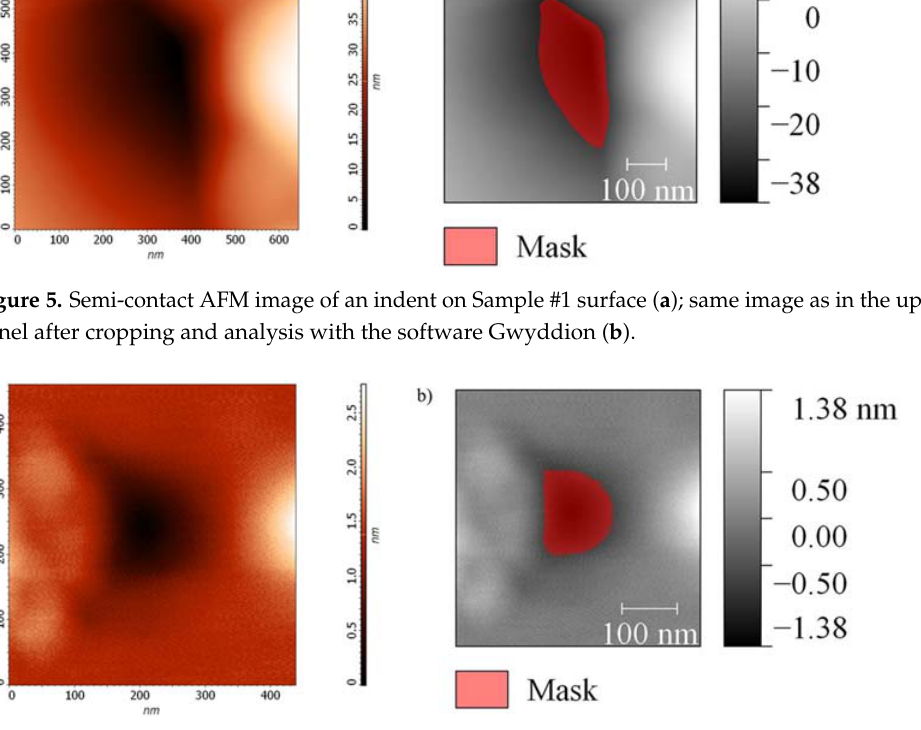
Figure 6. Semi-contact AFM image of an indent on Sample #2 surface ( a ); same image as in the upper panel after cropping and analysis with the software Gwyddion ( b ).